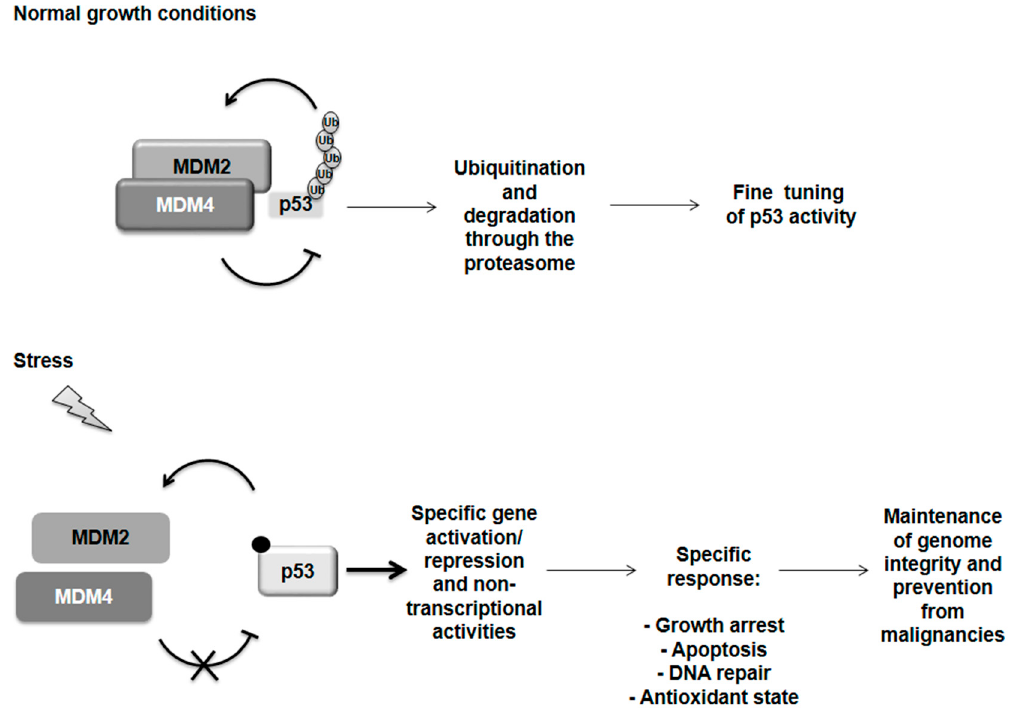
Figure 1. p53 regulation. Under normal growth conditions p53 is tightly controlled by its two main regulators, MDM2 and MDM4 proteins. Both can inhibit p53 transactivation activity. MDM2 is able to ubiquitinate p53 addressing it for degradation through the proteasome but it is sustained in this activity by the formation of a heterodimer with MDM4. Following severe stress, the MDM2 and MDM4 proteins dissociate by a still undefined mechanism while a variety of post-translational modifications are known for p53 (i.e., phosphorylation and acetylation). p53 is now free and active to orchestrate a response specifically related to the incoming stress and subsequently restore the normal condition by controlling its own regulator MDM2 in a negative feedback loop. However, if the damage is too severe, p53 can switch on programmed cell death in order to maintain genome integrity and prevent malignancies.